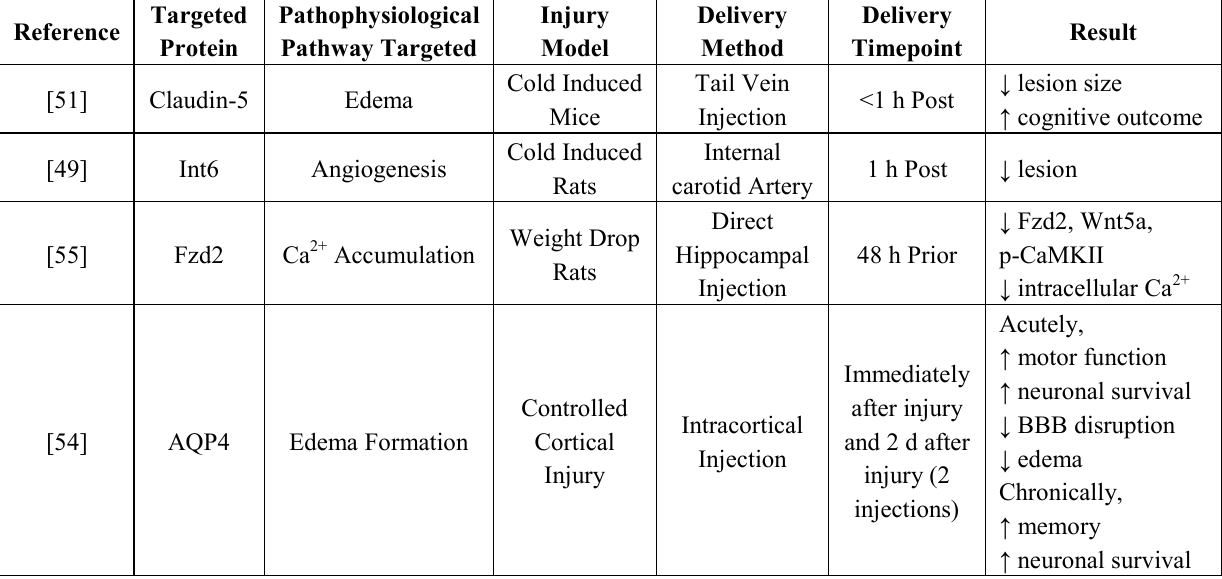
Table 3. Published in vivo usage of RNA interference as a therapeutic tool in traumatic brain injury